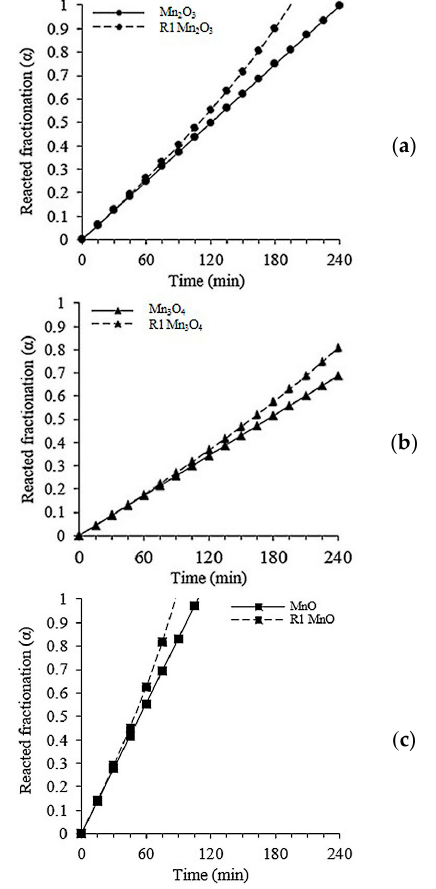
Figure 6. Comparison of the theoretical behavior of the different manganese oxidation states with the R1 model present in the aluminothermic reduction process ( a ) Mn 2 O 3 , ( b ) Mn 3 O 4 and ( c ) MnO. By globally analyzing the behavior of each one of the oxides, and by applying theoretical data and models of three-dimensional contraction, it can be established that the reduction of Mn 2 O 3 to